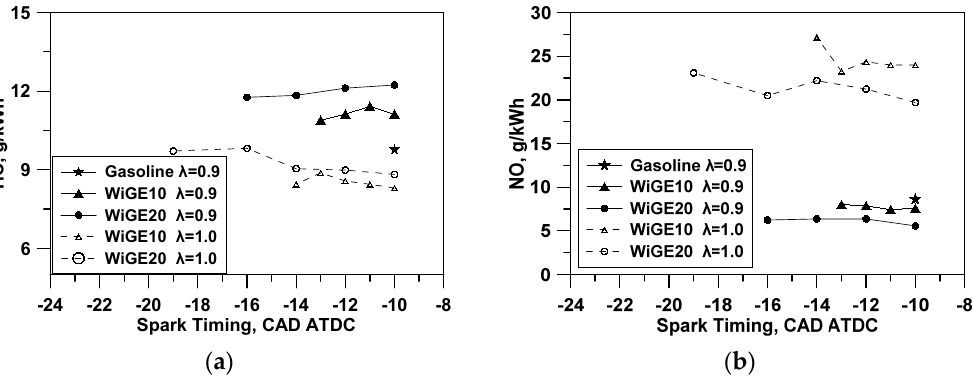
Figure 7. HC ( a ) and NO ( b ) emissions against spark timing and relative air-to-fuel ratio.